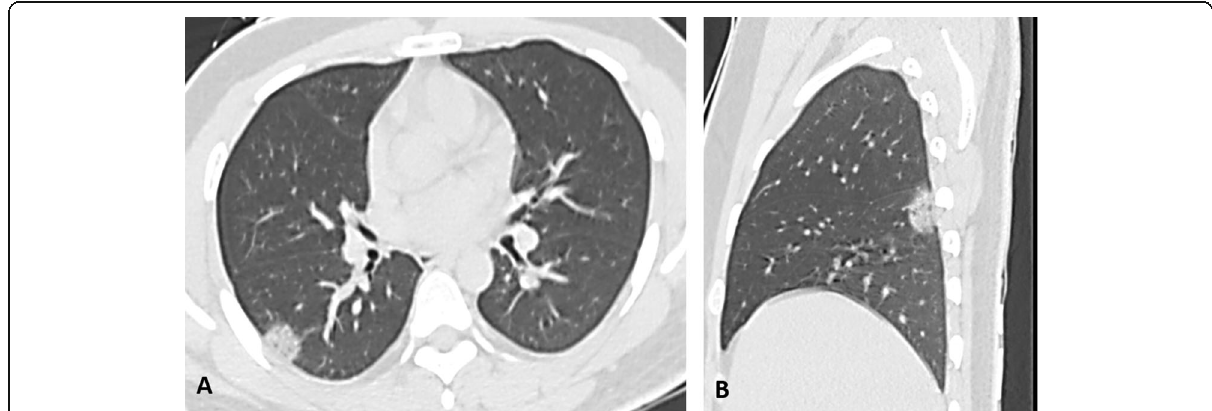
Fig. 2 Non-contrast CT of a 36-year-old male with fever, sore throat, and body ache, rt RT-PCR +VE ( A and B ): A , axial and B , sagittal non-contrast CT scan in lung window show peripheral single ground glass opacity in the apical segment of the right lower